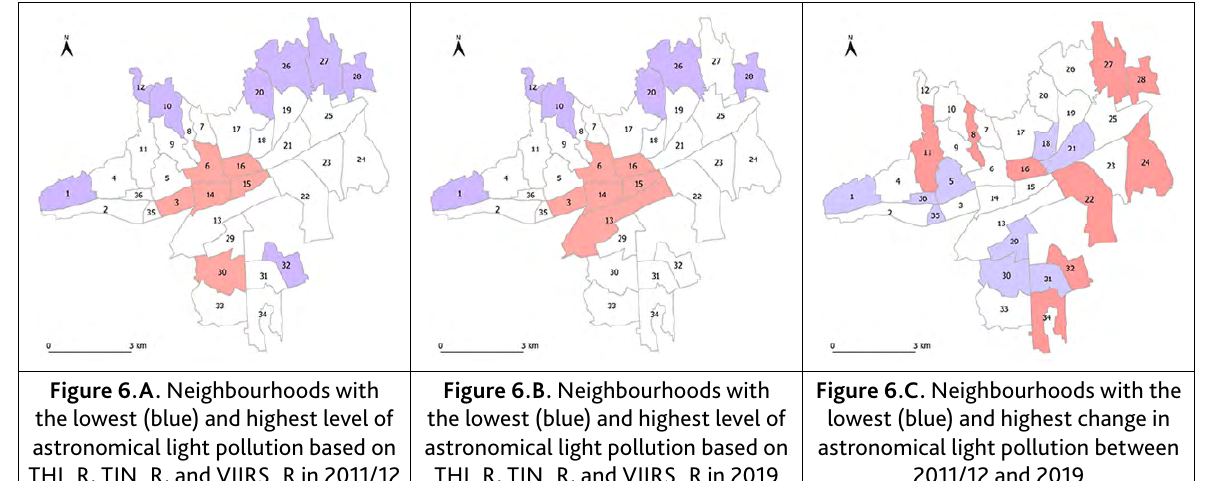
Figure 6.A. Neighbourhoods with the lowest (blue) and highest level of astronomical light pollution based on THI_R, TIN_R, and VIIRS_R in 2011/12